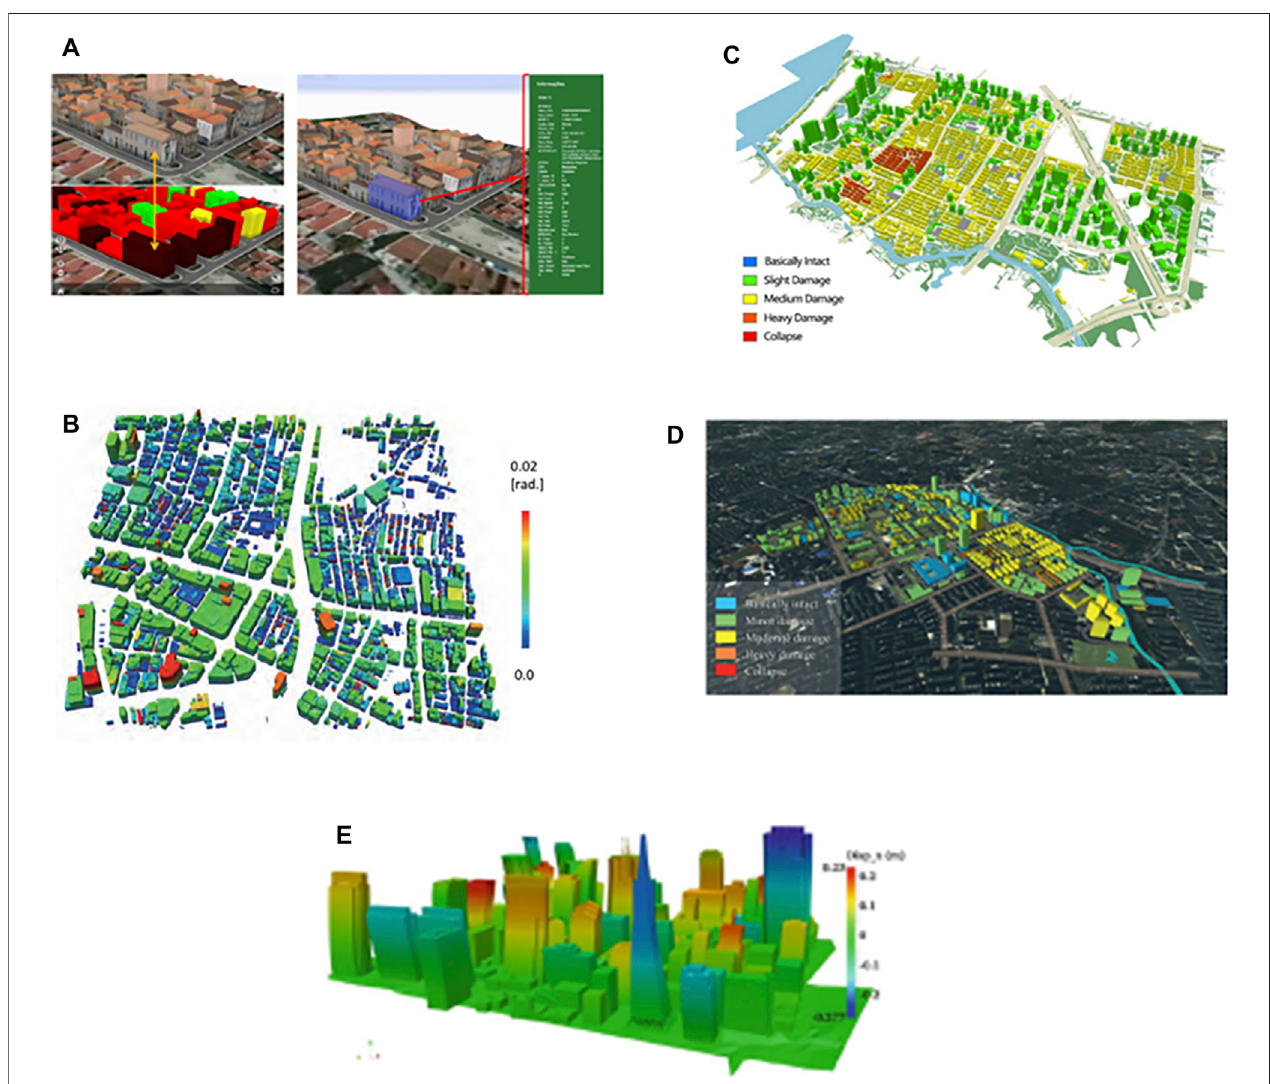
FIGURE1| Examplesof3Durbanearthquakeimpactmodels:modelsof (A) Redwelketal.(2017), (B) HoriandIchimura(2018), (C) Zhaietal.(2019), (D) Zhaiand Chen (2020), and (E) Lu and Guan (2021)